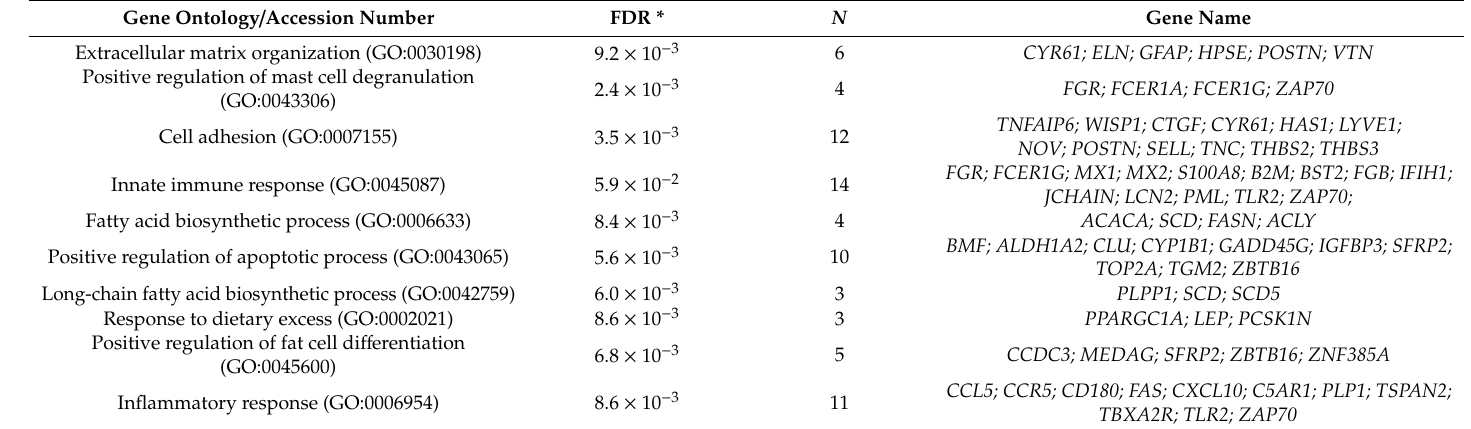
Table 2. Significant, enriched Gene Ontology terms for di ff erentially-expressed genes (DEGs) in relation to backfat thickness. Gene Ontology / Accession